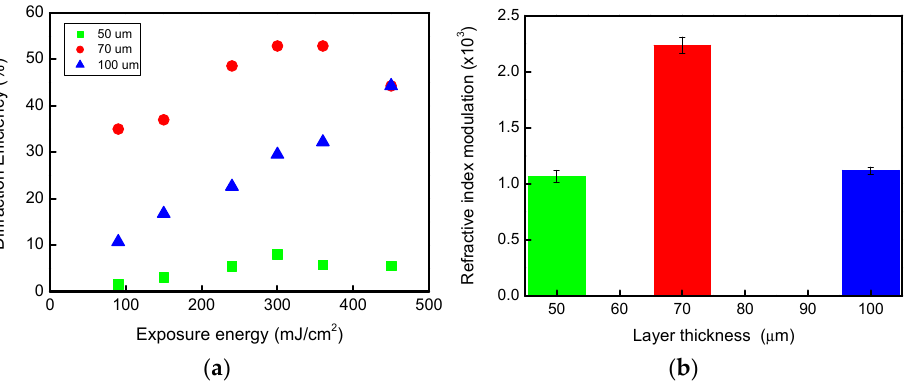
Figure 7. ( a ) Measured diffraction efficiency vs. exposure energy for the volume transmission gratings recorded in composition C with varying recording intensities 3–10 mW/cm 2 at fixed time 30 s and spatial frequency of 800 l/mm was investigated for sample thickness of 50, 70 and 100 μ m (±5 μ m) layers, ( b ) ∆ n vs. layer thickness 50–100 μ m ± 5 μ m for CA–PEG photopolymer composition.